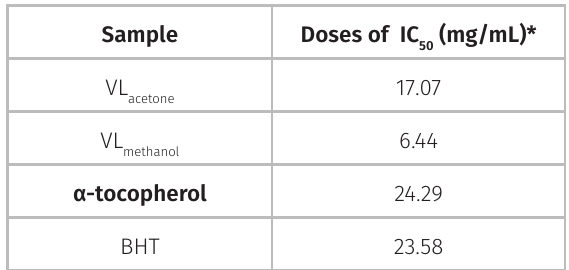
Table I. The IC antioxidants and VL DPPH